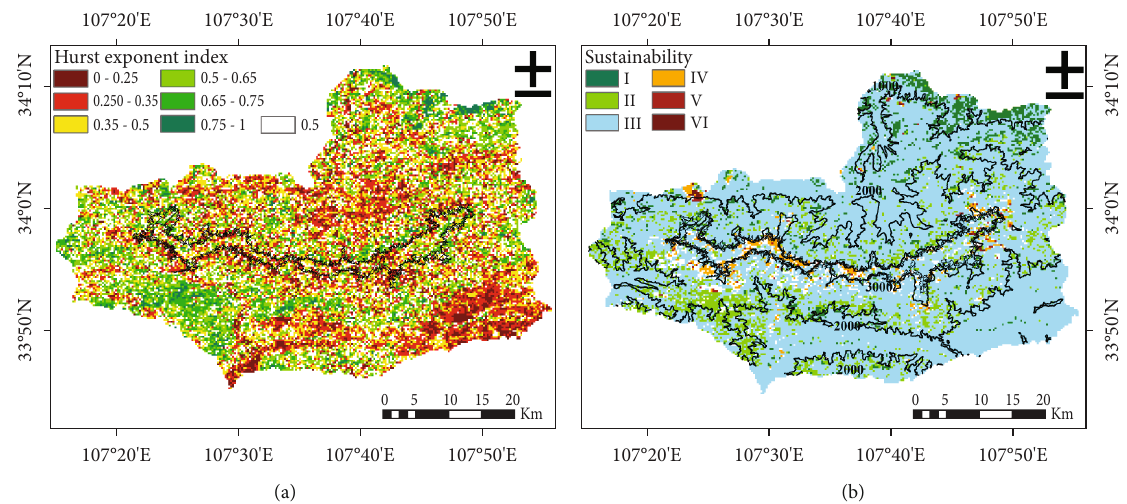
Figure 9: Future vegetation trends and the sustainable spatial distribution of Taibai Mountain: (a) spatial distribution of the Hurst exponent and (b) the NDVI sustainability obtained by superposition of the Hurst exponent and the NDVI